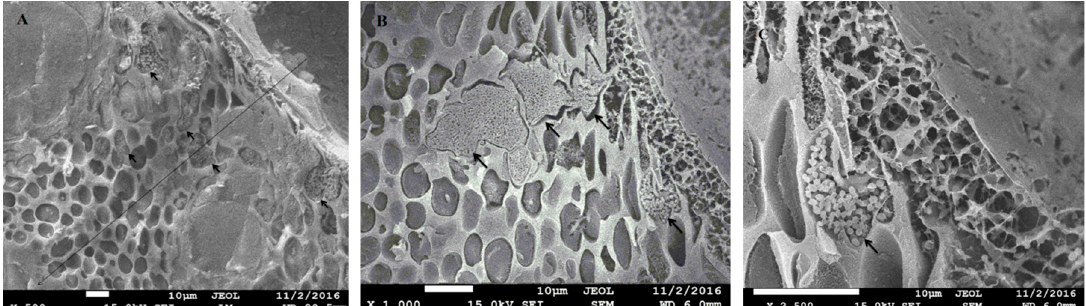
Figure 3. Images of spontaneous immobilization of C. butyricum adjacent to the PVA particle surface, as captured by the electron microscope JEOL 7500F using KRYO system Quorum at resolution (A) x500 (B) x1000 and (C) x2500